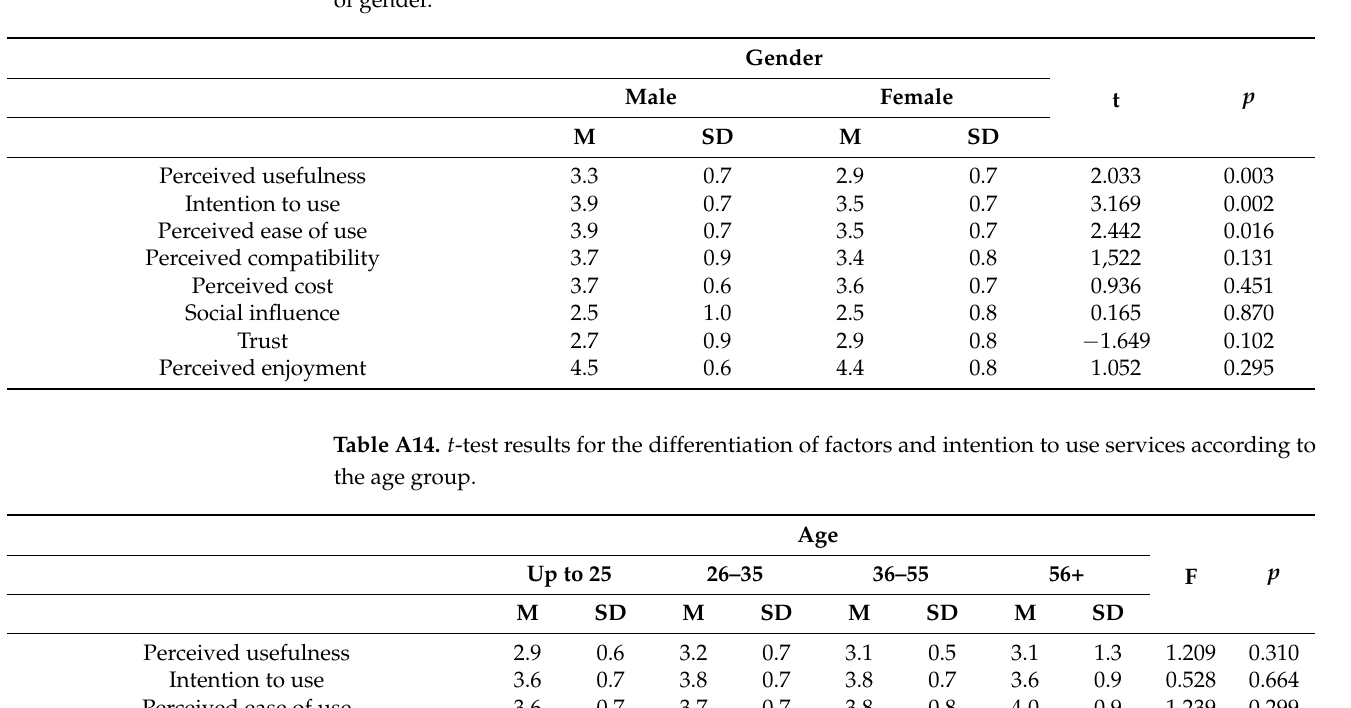
Table A13. t -test results for the differentiation of factors and intention to use services in terms of gender.